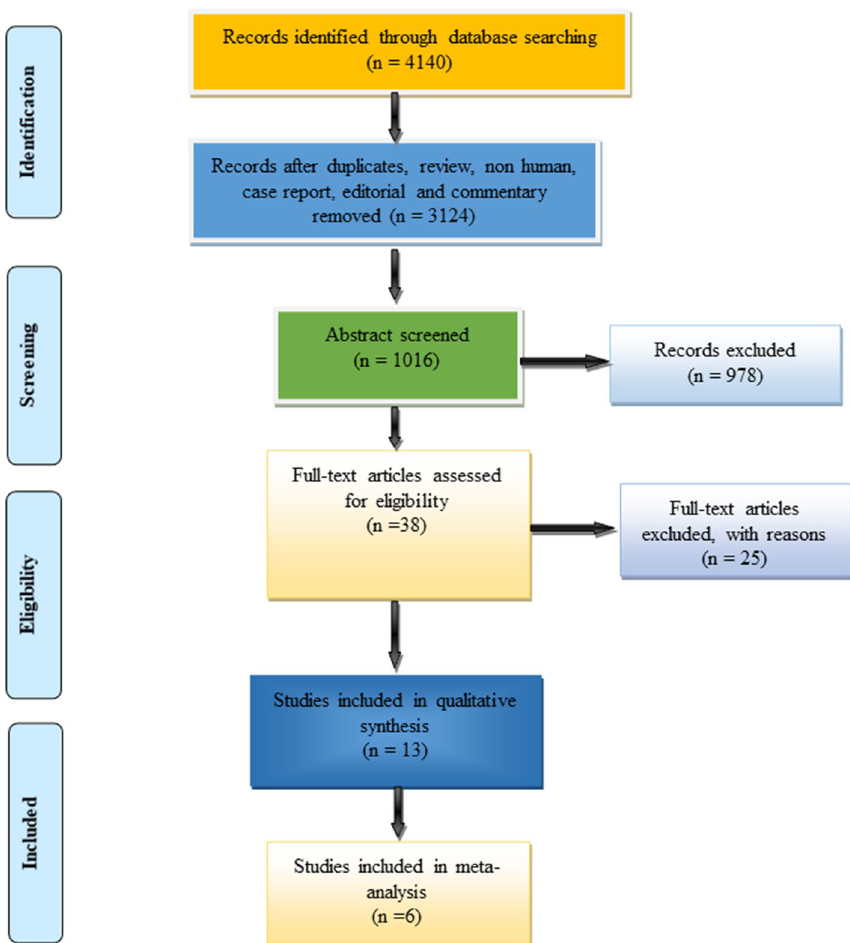
Figure 2. PRISMA flow diagram of the search strategies.